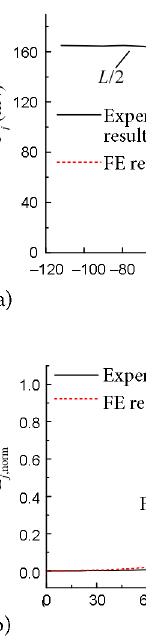
Figure 13. The comparison of the experimental and simulative results of arch A: a – the F j - d curve; b – the E j ,norm - F j